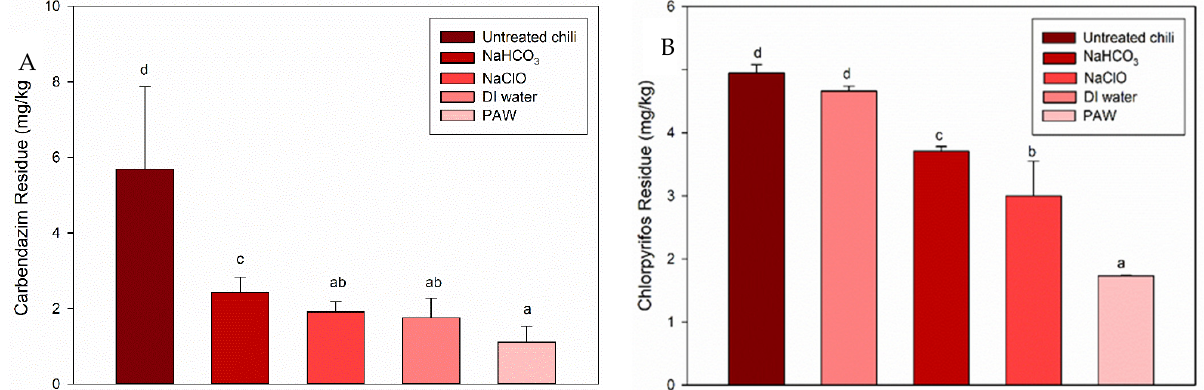
Figure 5. The residues of ( A ) carbendazim, and ( B ) chlorpyrifos in chili for untreated chili and treated with NaHCO 3 , NaClO, DI water, and PAW. Error bars indicate standard deviation ( n = 3). Different letters indicate the significantly different among treatments ( p < 0.05).